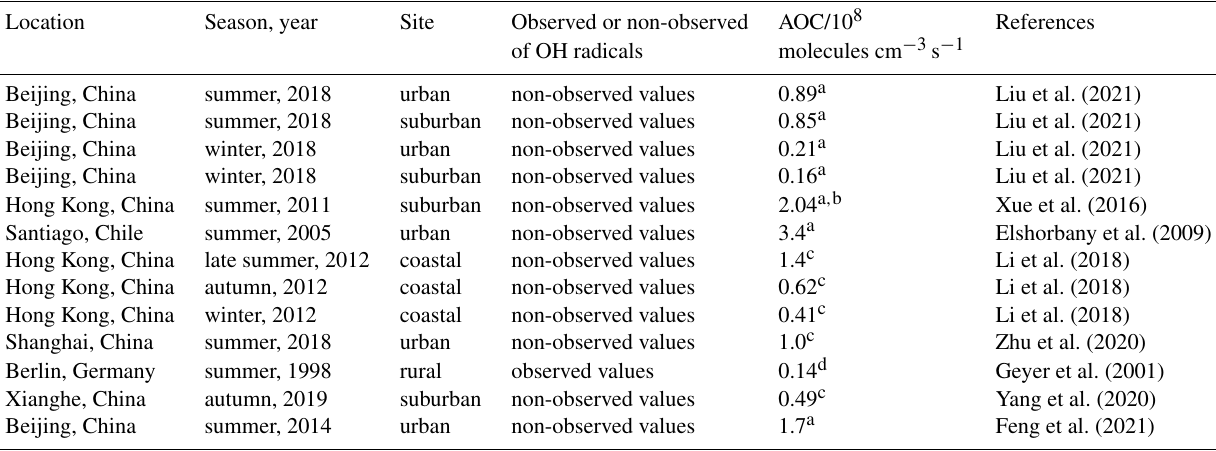
Table 1. Summary of OH concentrations and AOC values reported in previous field campaigns.